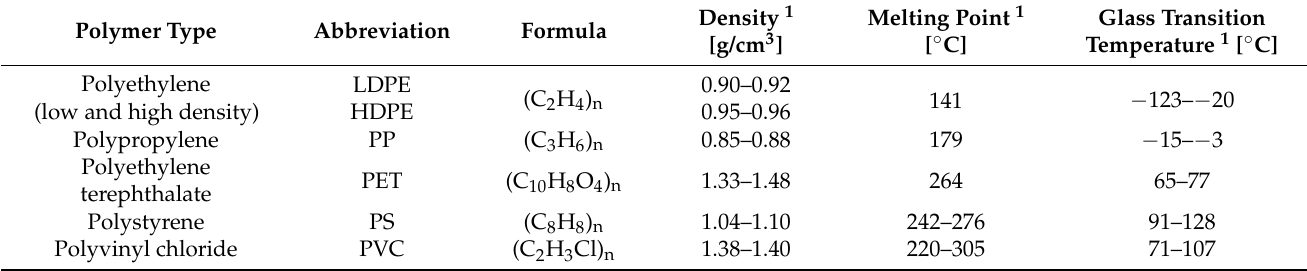
Table 1. Characteristics of the most common polymer types of microplastics (MPs) found in the environmental samples. Polymer